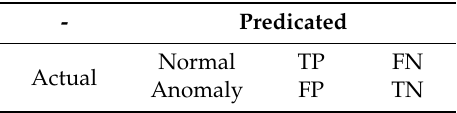
Table 6. Confusion matrix for the proposed ID system.